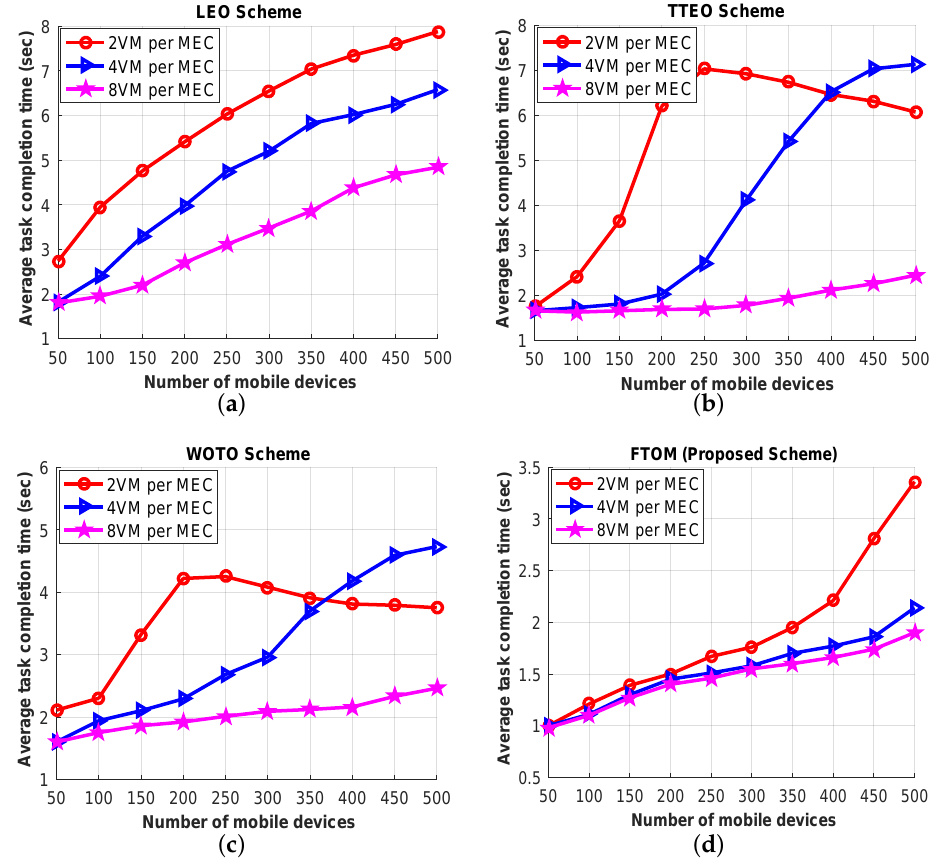
Figure 15. Performance evaluation based on each application types for different VM condition: ( a ) LEO scheme; ( b ) TTEO scheme; ( c ) WOTO scheme; ( d ) FTOM